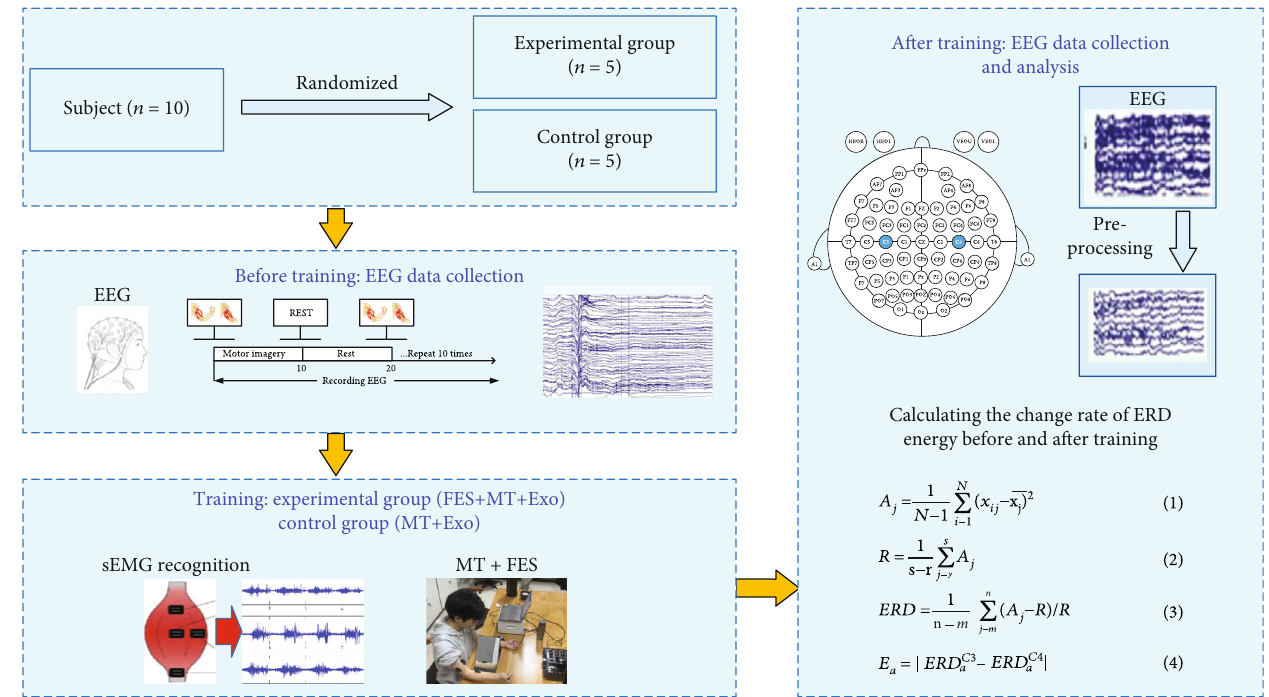
Figure 4: Experimental design fl ow.